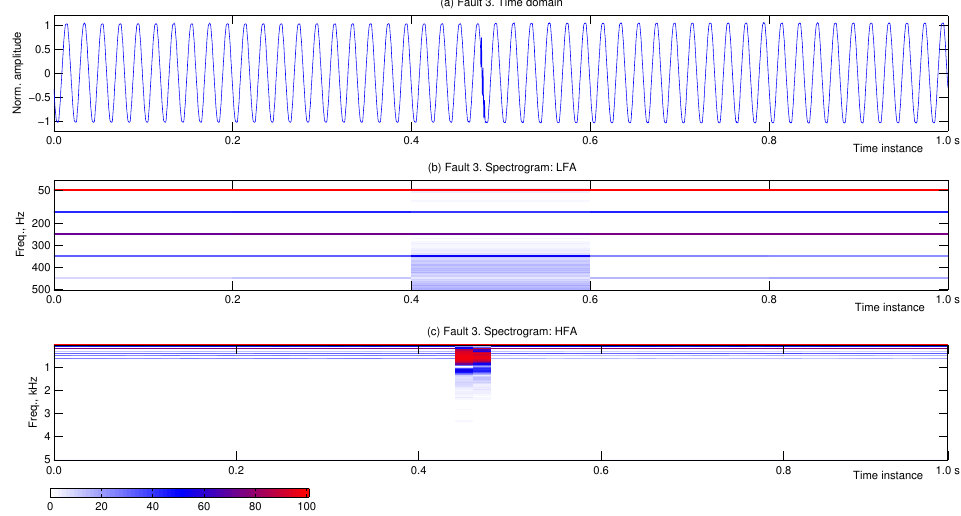
Figure 5. Fault #3: Oscillatory transient of 700 Hz and a duration of 8 ms (upper subfigure). The HFA module produces a more acute detection zone (third subfigure).